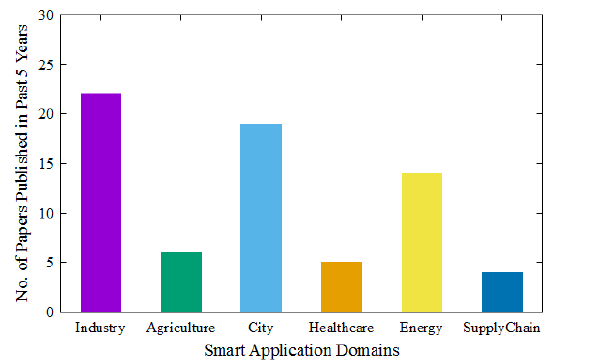
Figure 2. Number of papers published in major IoT application